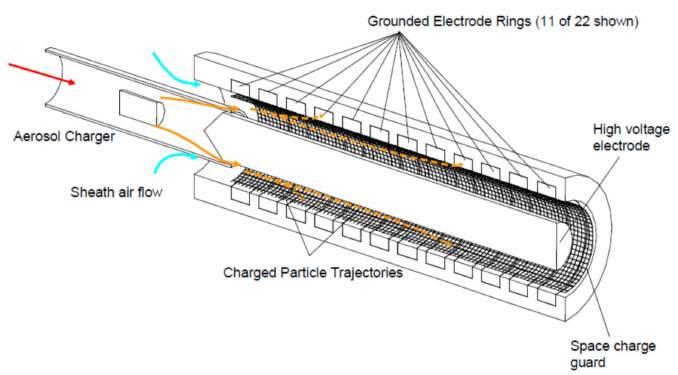
Figure 6. Schematic diagram of classifier column and charger inside DMS-500 system.